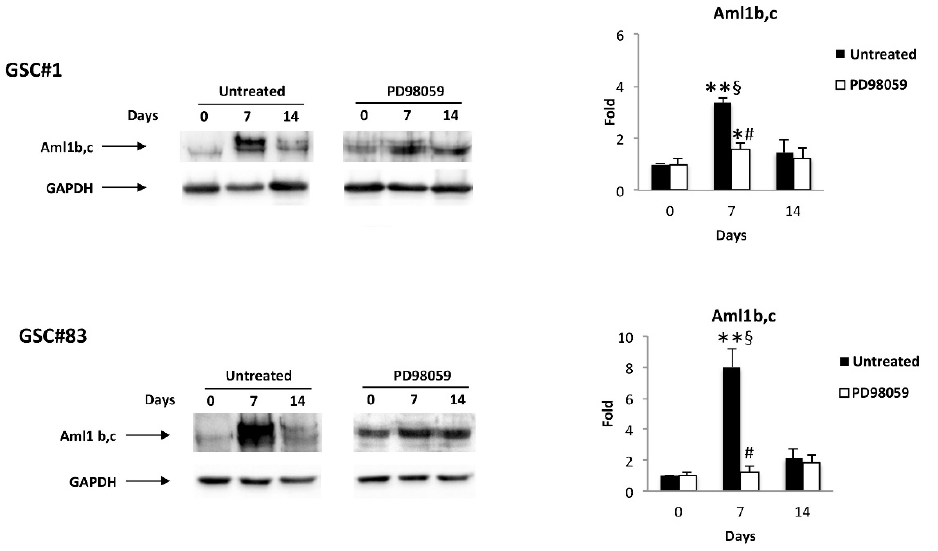
Figure 4. Aml1 splice variant modulation during GSC differentiation: western blot analysis of Aml1b and Aml1 c protein levels in GSC#1 and GSC#83 untreated or treated with PD98059 for up to 14 day of differentiation. Blots are representative of one of three separate experiments. Aml1 b/c densitometry values were normalized to GAPDH used as loading control. * p < 0.05 vs. undifferentiated cells (time 0); ** p < 0.001 vs. undifferentiated cells (time 0); # p < 0.001 vs. untreated cells; § p < 0.001 vs. 14 days of